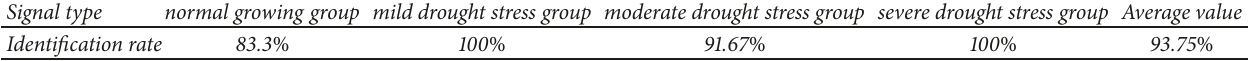
Table 9: The experimental result of BP neural